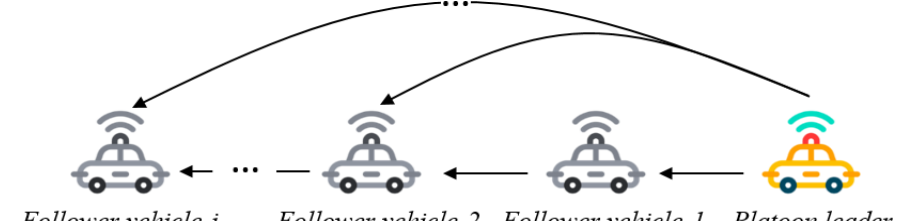
Figure 1. The information transfer topology diagram in a vehicle platoon.